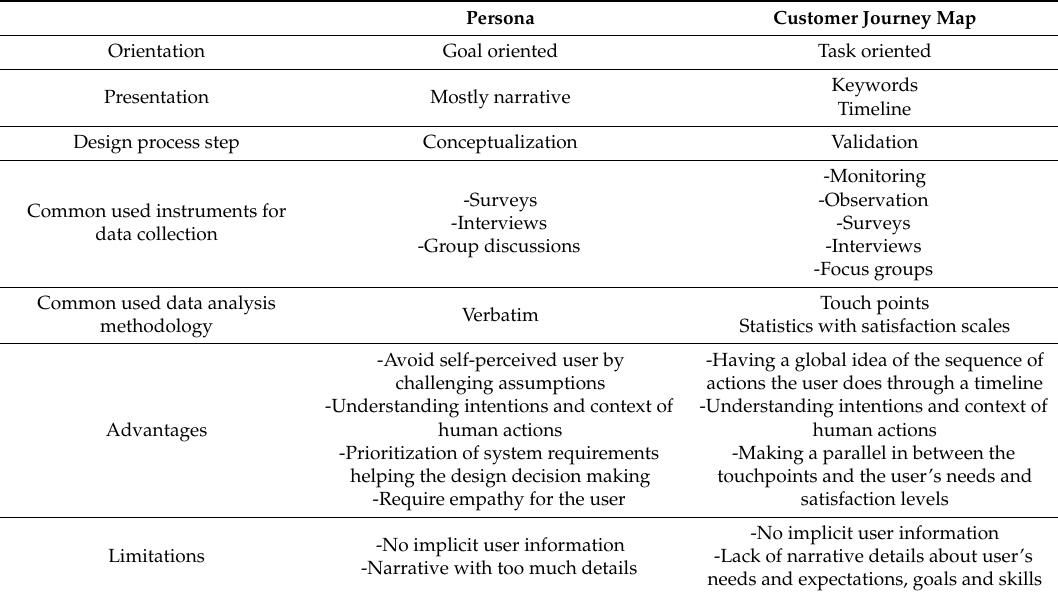
Table 2. Summary of the Persona and Customer Journey map